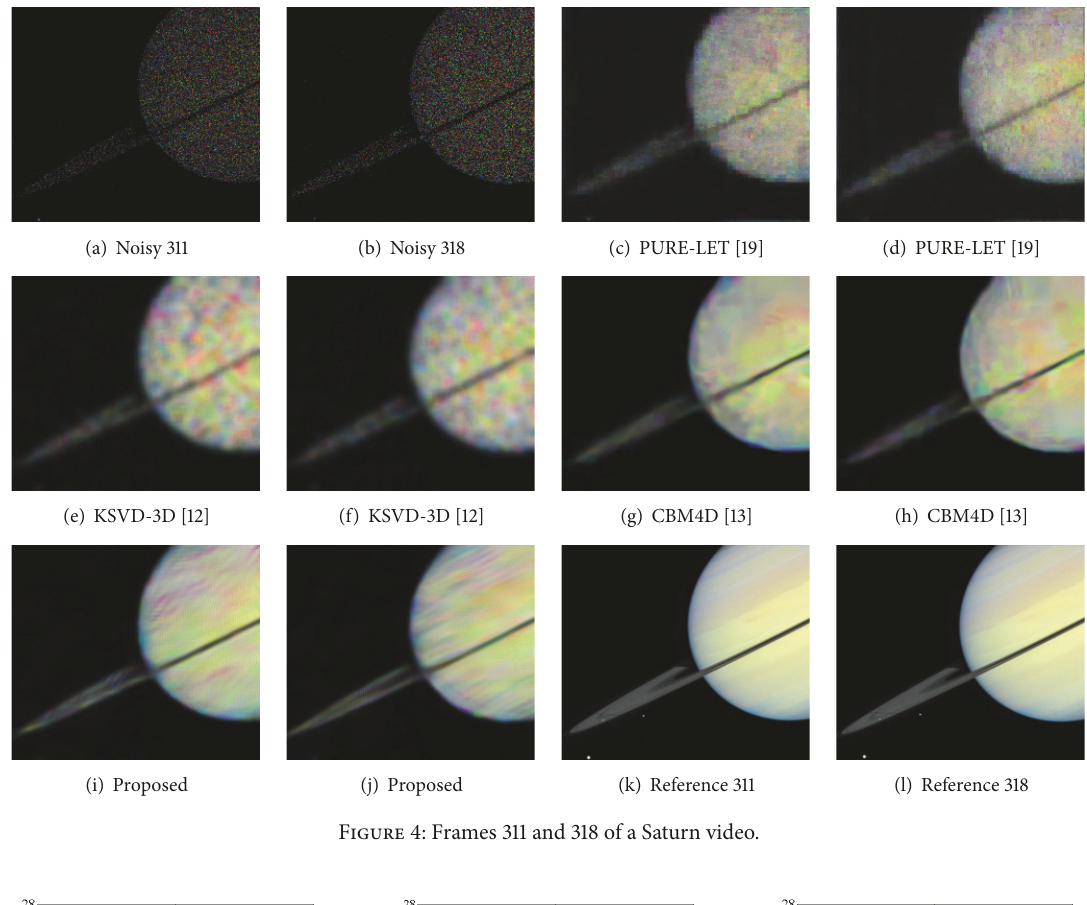
Figure 4: Frames 311 and 318 of a Saturn video.